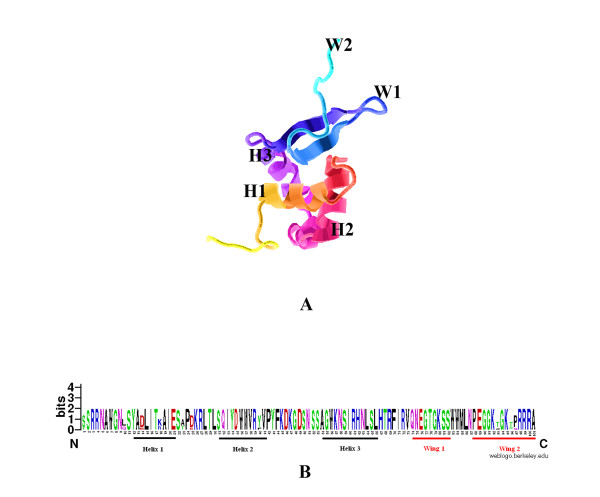
The modeled structure of mouse Foxo6. A. The structure of the forkhead domain; B. Sequence logo of the forkhead domain and surrounding amino acids.